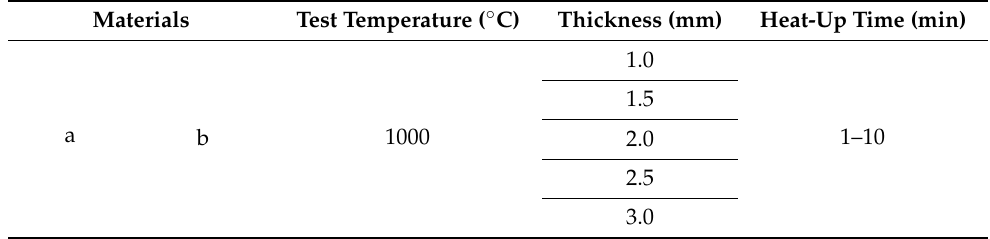
Table 2. Thermal deformation test design of